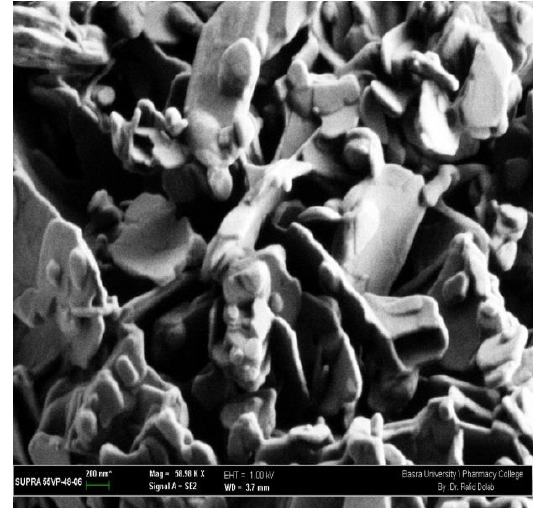
Figure 5. FESEM of pure domperidone withmagnification power of